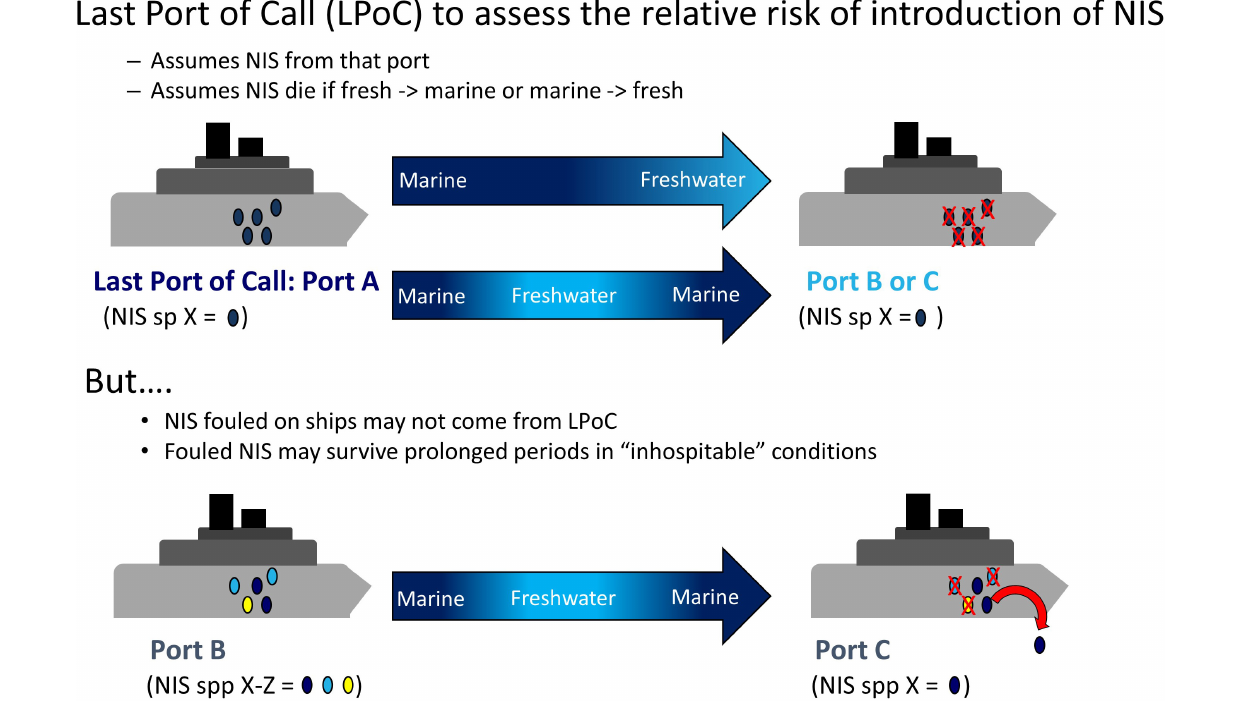
FIGURE 1 | Conceptual diagram of transit between ports. Biofouling risk assessments only consider Last Port of Call (LPoC), but biofouling organisms from other ports with similar conditions can also be found. NIS, non-indigenous species.